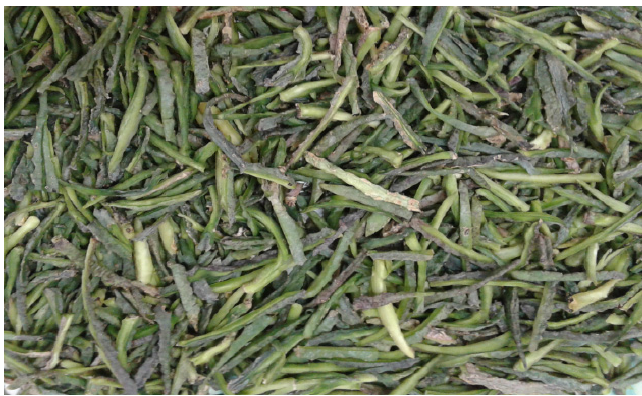
Figure 1. Aerial parts of A. europaea